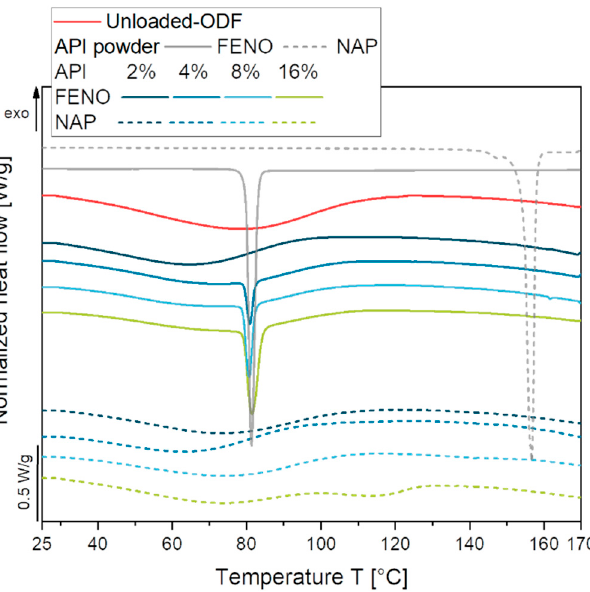
Figure 4. DSC melting curves of ASD-ODFs containing different concentrations of FENO and NAP, measured one day after film